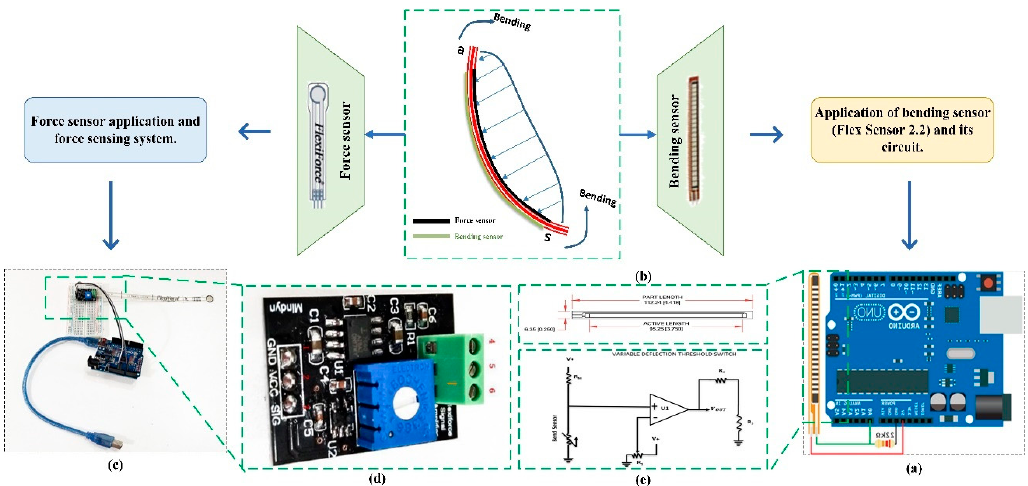
Figure 4. Distribution of various sensors of manipulator. ( a ) Diagram of bending sensor application simulation. ( b ) Dimensional diagram—flex sensor. ( c ) Experimental setup to evaluate the grasping force. ( d ) The signal amplification circuit. ( e ) Variable deflection threshold switch.